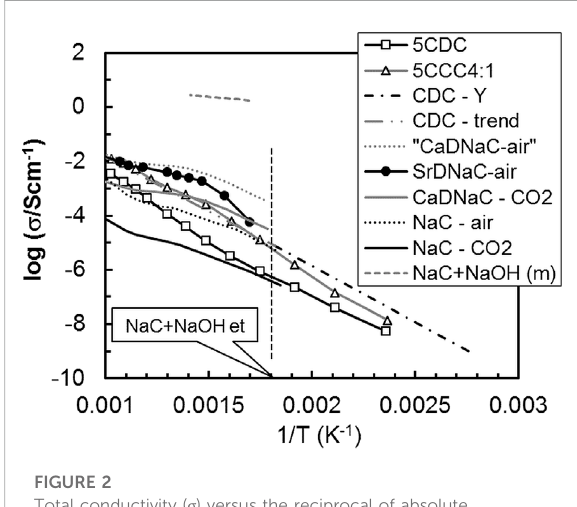
FIGURE 1 Estimated volume fraction of second phases and different grain sizes, based on the brick-layer model ( see section 5 for details). Materials considered here are identi fi ed in Table 3.